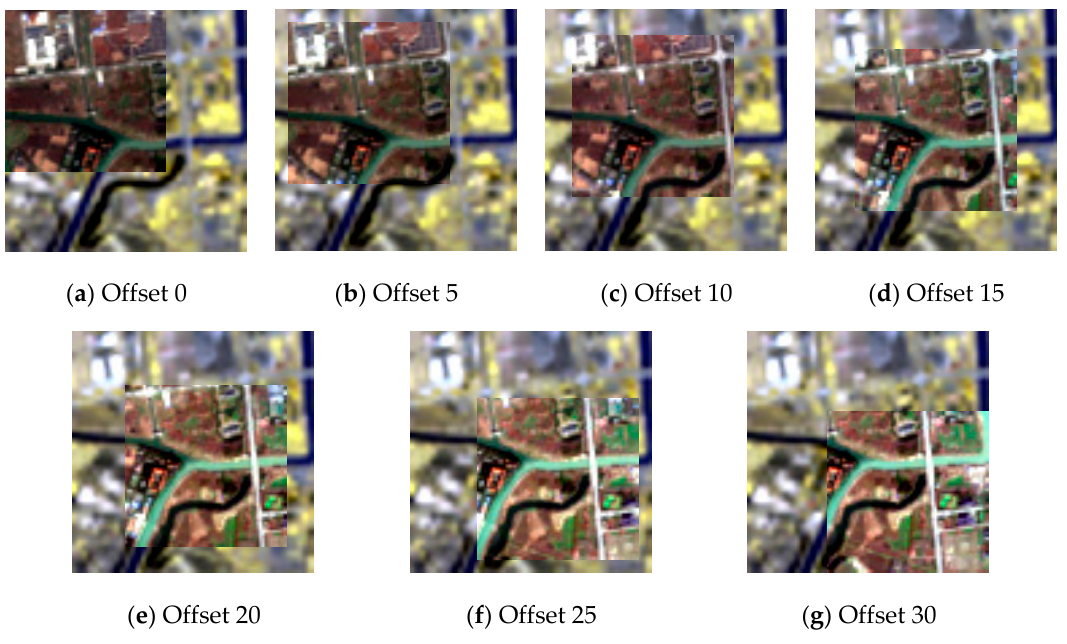
Figure 9. The data coverage in the offset position experiment.